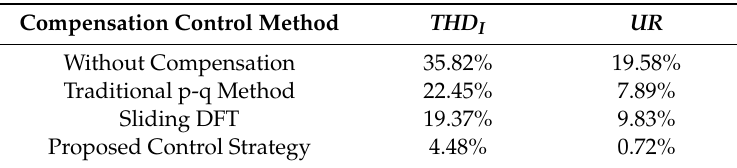
Table 3. Compensation results for case